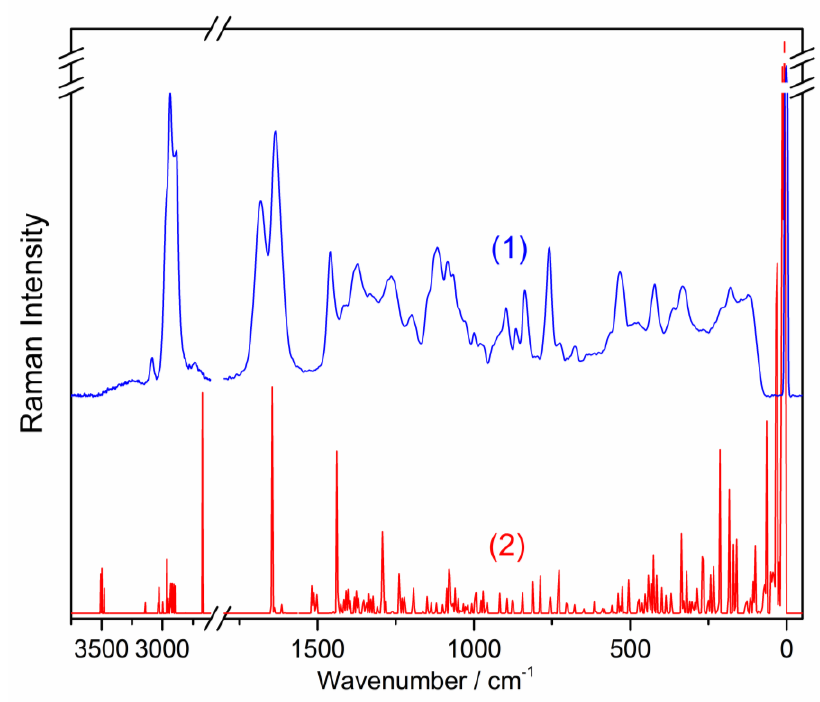
Figure 3. Raman spectra of the studied loganic acid: (1) observed, (2) simulated .